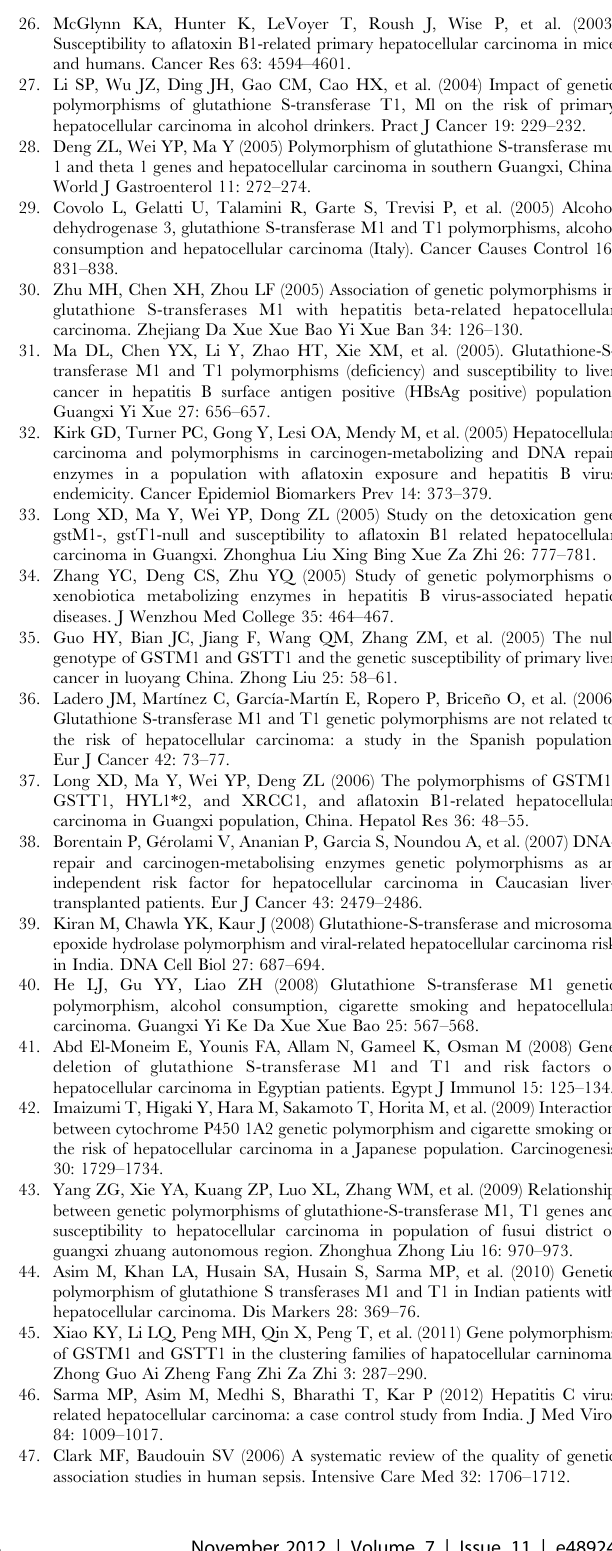
Figure S3 Begg’s funnel plot for publication bias in selection of studies on GSTT1